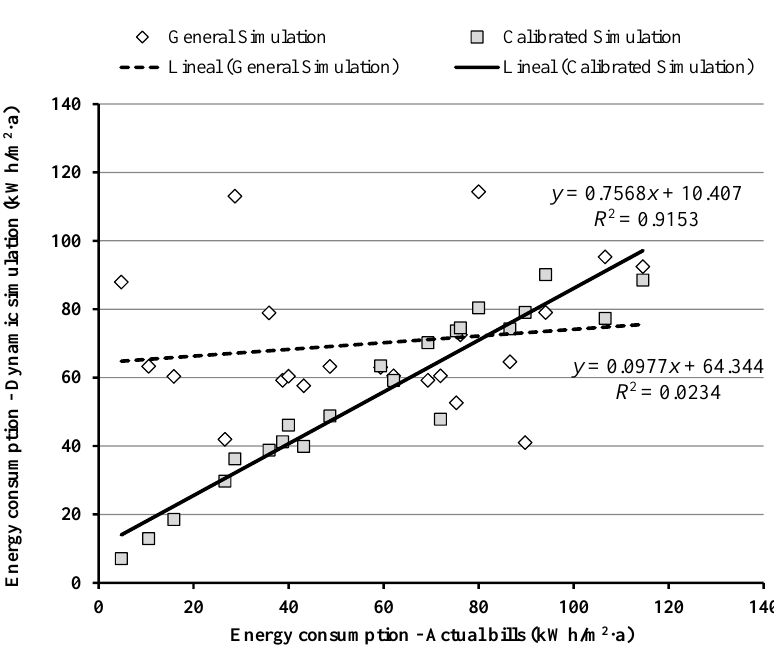
Fig. 2. Energy consumption for general simulation versus actual energy bills and calibrated simulation versus actual energy with linear